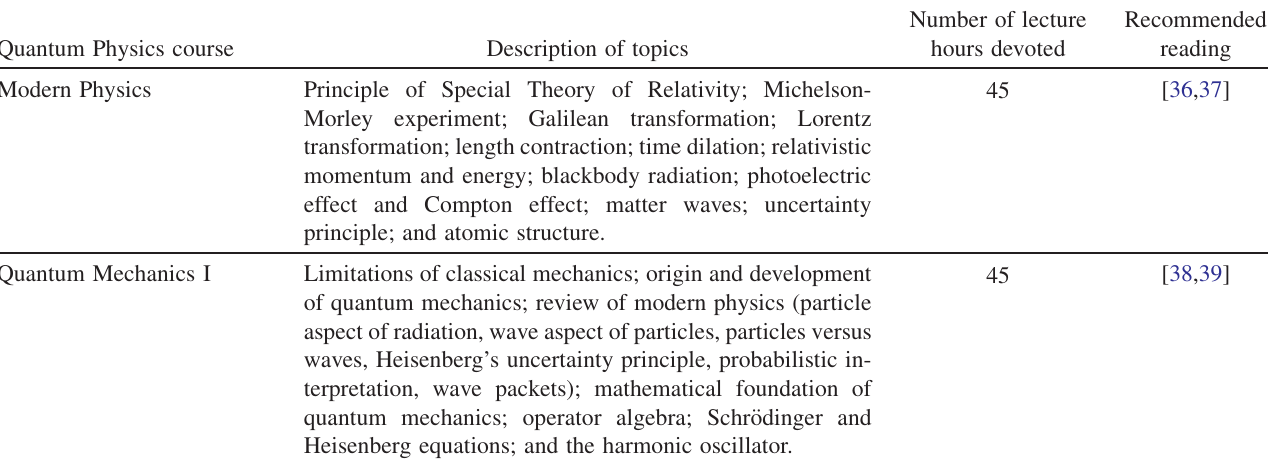
TABLE I. Summary of the two Quantum Physics courses completed by students who were recruited for interviews, including the descriptions of the progression topics, total number of lecture hours devoted, and reference books used for each Quantum Physics